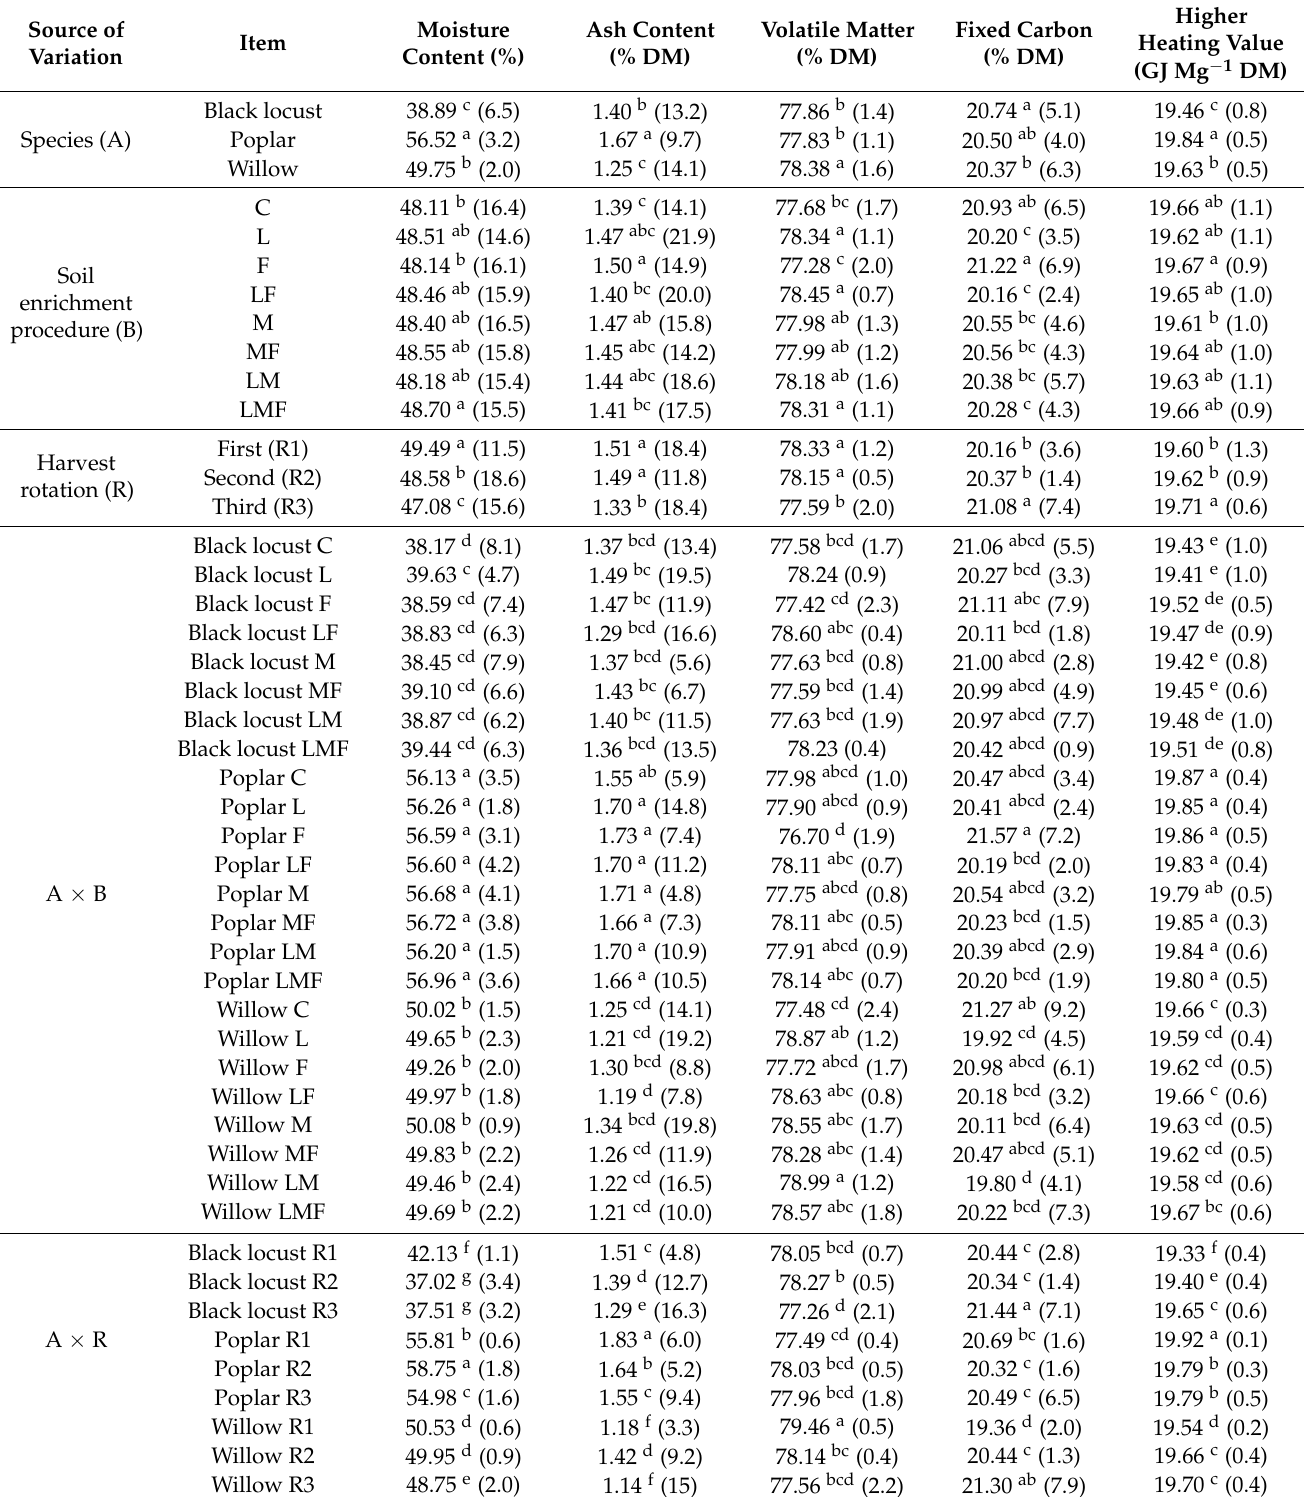
Table 2. Selected thermophysical properties of the short-rotation woody crop (SRWC) biomass depend- ing on the species and the soil enrichment procedure in three consecutive four-year harvest